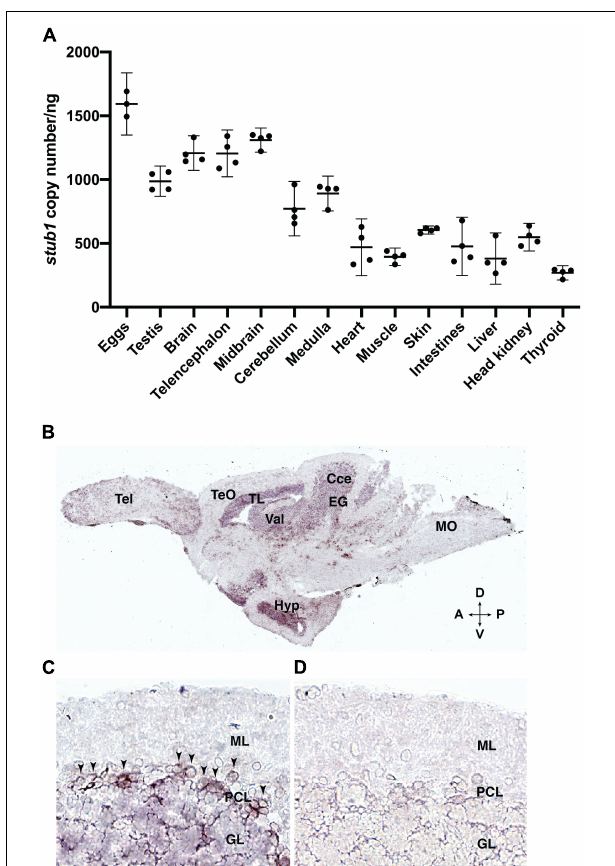
FIGURE 2 | stub1 mRNAs are expressed in different tissues and in the Purkinje cells of adult zebrafish cerebellum. (A) Scatter plot of ddPCR data presenting the absolute number of stub1 transcripts per ng of cDNA for different zebrafish tissues. Each dot represents a biological replicate. Means and standard deviations are indicated by the lines and bars in the graph ( n = 4). (B) DIG-labeled stub1 cDNA probes were synthesized, and used for visualization of stub1 mRNA expression in adult zebrafish brain sections, using in situ hybridization assay. (C) Detailed view of cerebellum where stub1 positive cells in the Purkinje cell layer are indicated by arrowheads. (D) Negative control corresponding to the same area as shown in (B) . Tel, telencephalon; TeO, tectum opticum; TL, torus longitudinalis; Val, valvula cerebelli; Cce, Corpus cerebelli; EG, eminentia granularis; Mo, medulla oblongata; Hyp, hypothalamus; A, anterior; P, posterior; D, dorsal; V, ventral; ML, molecular layer; PCL, Purkinje cell layer; GL, granular